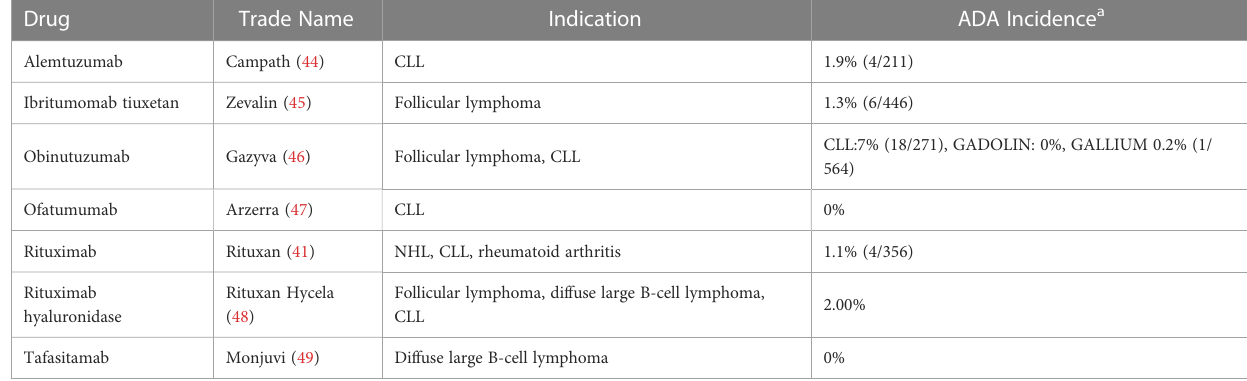
TABLE 7 ADA incidence for non-ADC immunotherapeutics approved for the treatment of NHL or CLL.